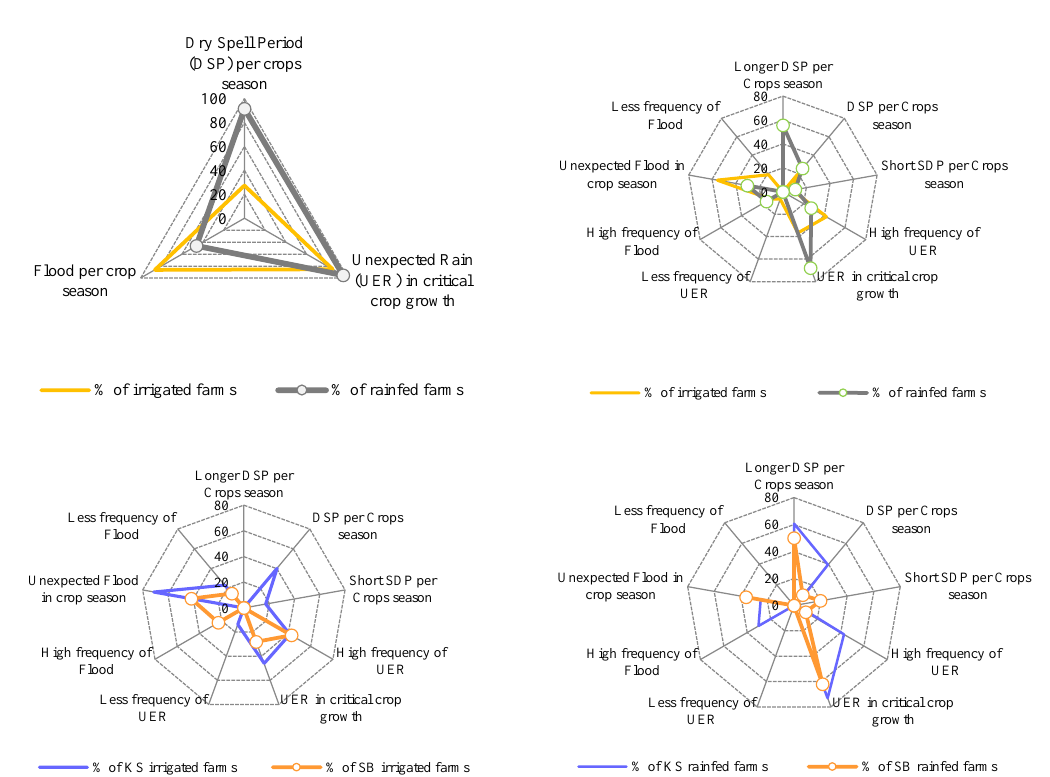
Figure 8. Specific climate stresses by irrigated and rainfed